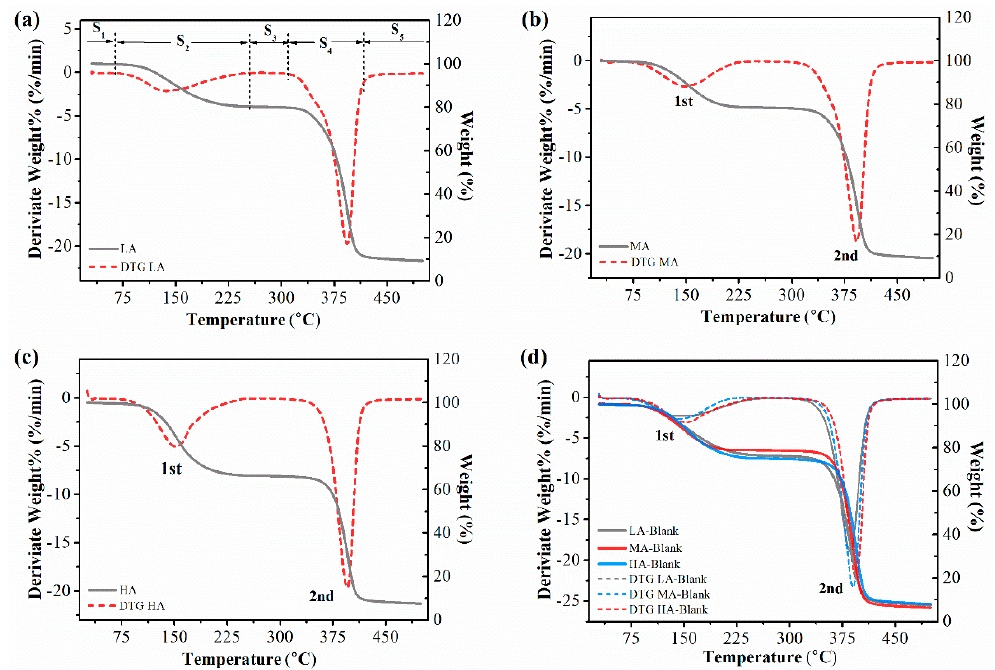
Figure 5. Thermogravimetric curves of starch-based nanocomposites with different amylose/amylopectin ratios and the control samples. Table 1. Peak temperature values (°C) of starch-based composites with and without nanofiller.